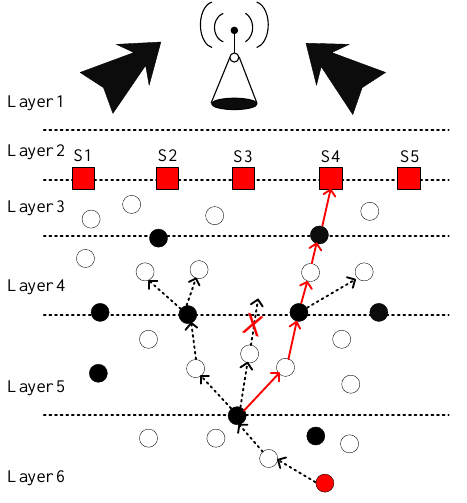
Figure 2. System Model of FLMPC-Two.